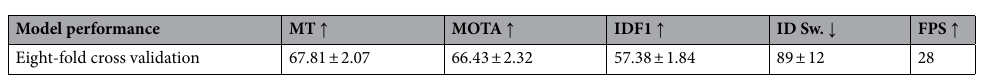
Table 2. DefectTrack ’s multi-object tracking performance. Average tracking performance and standard deviation on the eight test sets are presented here for eight-fold cross validation. Note that the up arrows indicate the higher the score the better the tracking performance, and vice versa. For details of the MOT metrics, see Supplementary Sect.